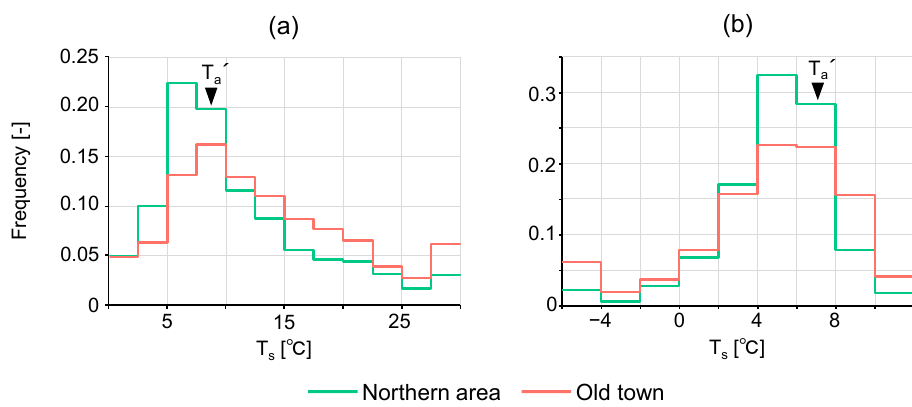
Figure 4. Histogram of remotely sensed T s for the northern area and the old town: ( a ) daytime and ( b ) after sunset. Representative air temperature (T a ′ ) is depicted for each time period.